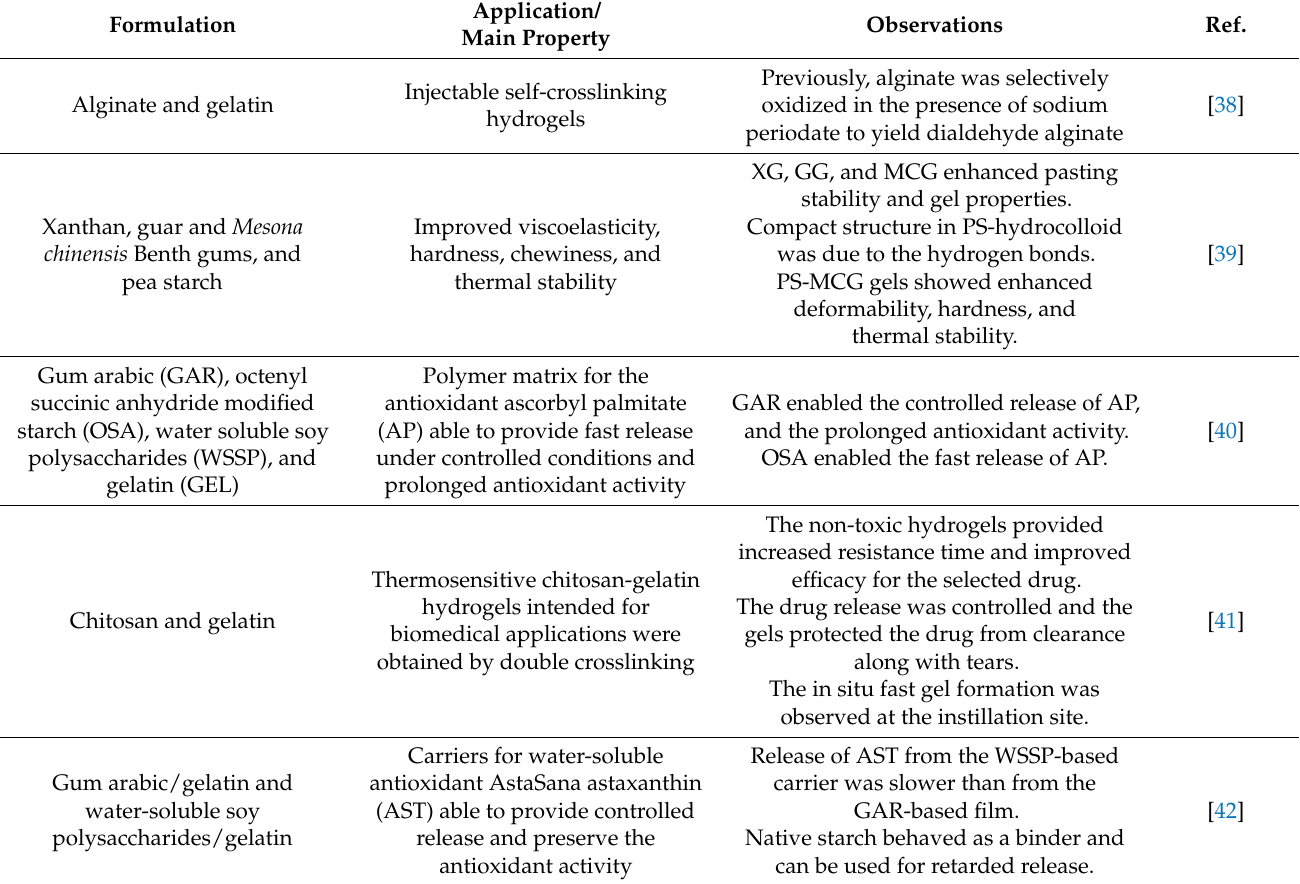
Table 1. Some novel formulations of polysaccharides and other components .